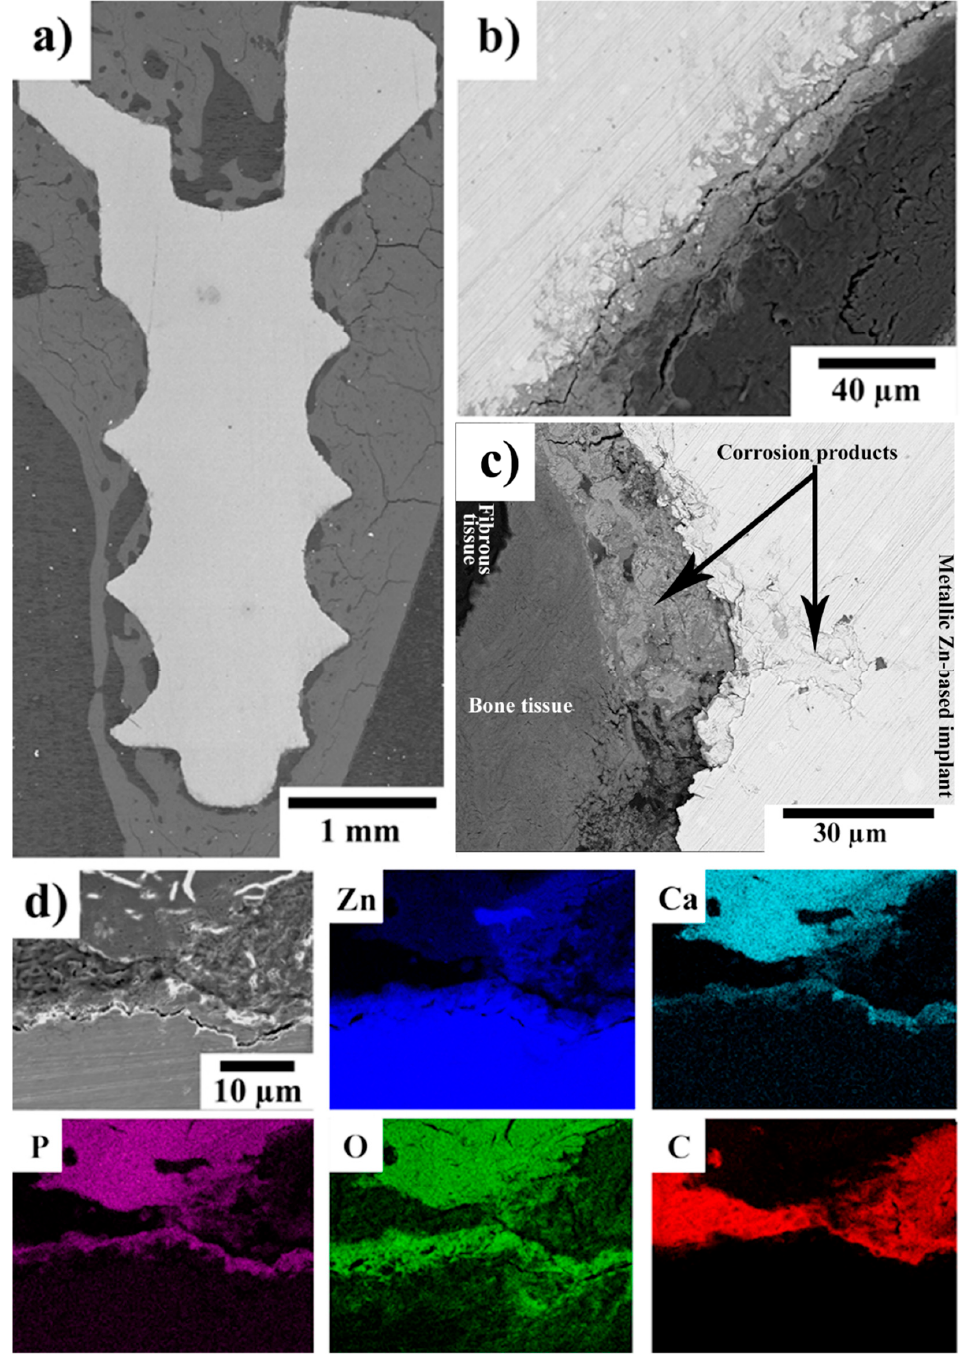
Figure 5. ( a – d ) SEM micrographs (Z ‐ contrast) of a Zn ‐ 0.8Mg ‐ 0.2Sr experimental screw 360 days after implantation in rabbit tibias. The X ‐ ray elemental maps showing the distributions of Zn, Ca, P, O, and C were acquired from the area shown in ( d ); the scale bar is the same as in ( d ). In ( b , c ), the gray shaded areas can be interpreted as follows: the lightest gray—metallic implant, light gray—corrosion products, dark gray—bone tissue and black/the darkest gray—fibrous tissue. In contrast to the experimental Zn ‐ based screw, the control Ti ‐ based screw (Figure 6) did not degrade, and most of its surface was surrounded by bone tissue.